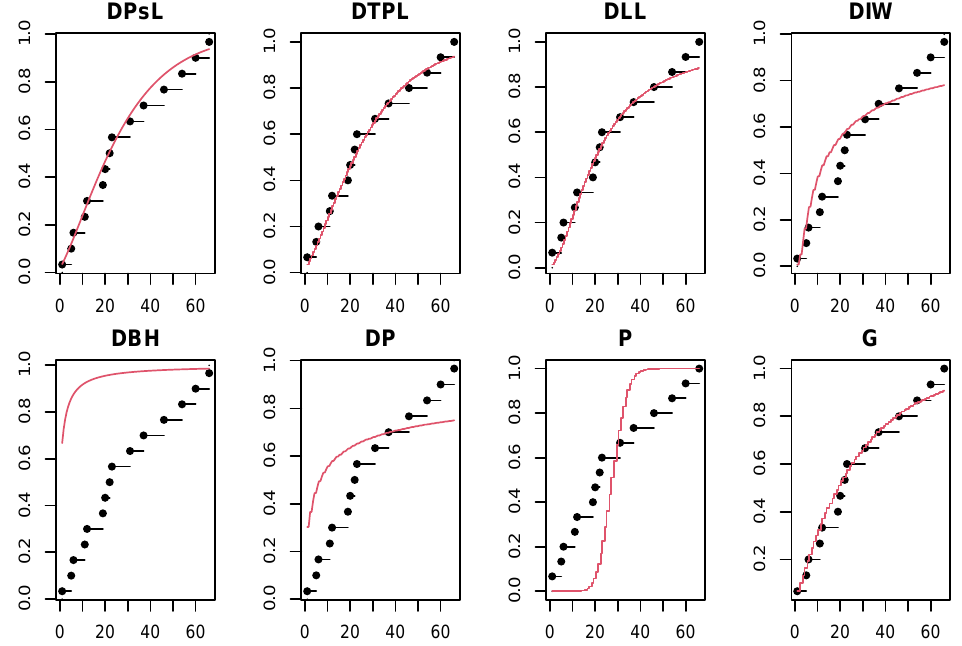
Figure 4. Estimated cdfs of the fitted distributions using the failure times data.